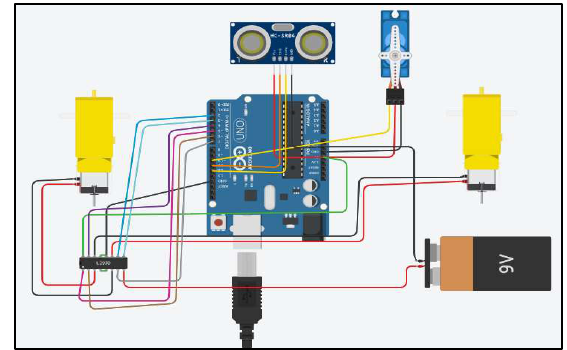
Fig. 8. Obstacle Avoidance System